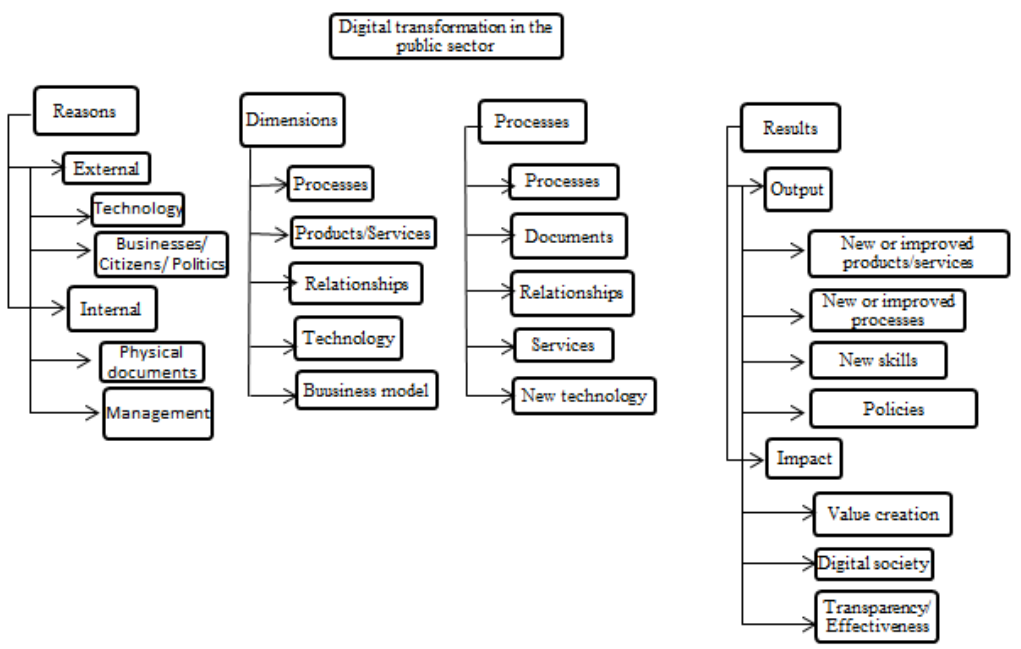
Figure 1. Classification of codes.